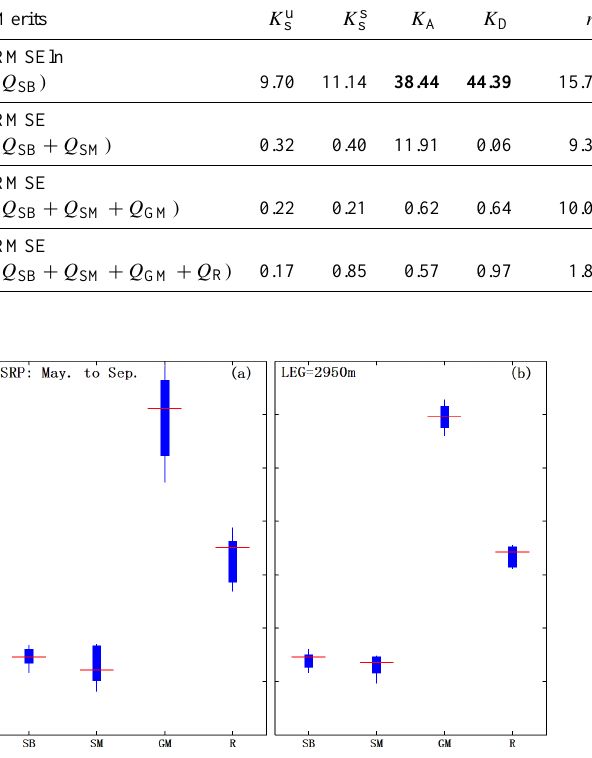
Table 7. R MS (%) for parameter sensitivity ( R MS values indicating the most sensitive parameters are labeled in bold). Subsurface Routing Infiltration Interception Rainfall runoff Melt Merits